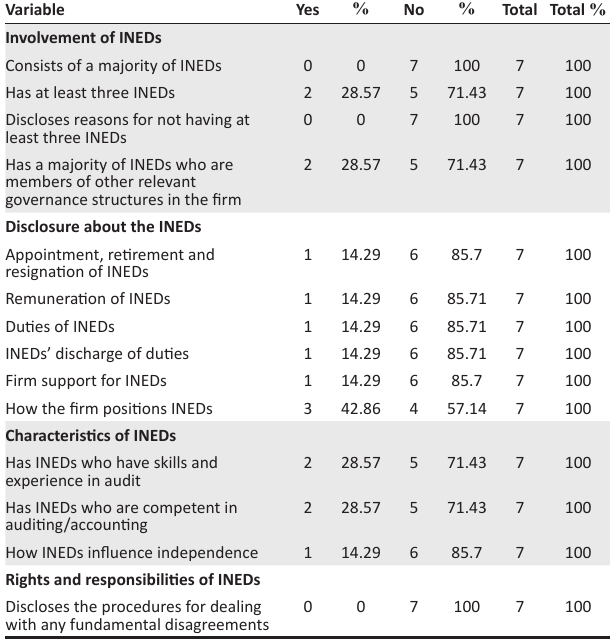
TABLE 4 : Findings on the independent non-executive director principle.